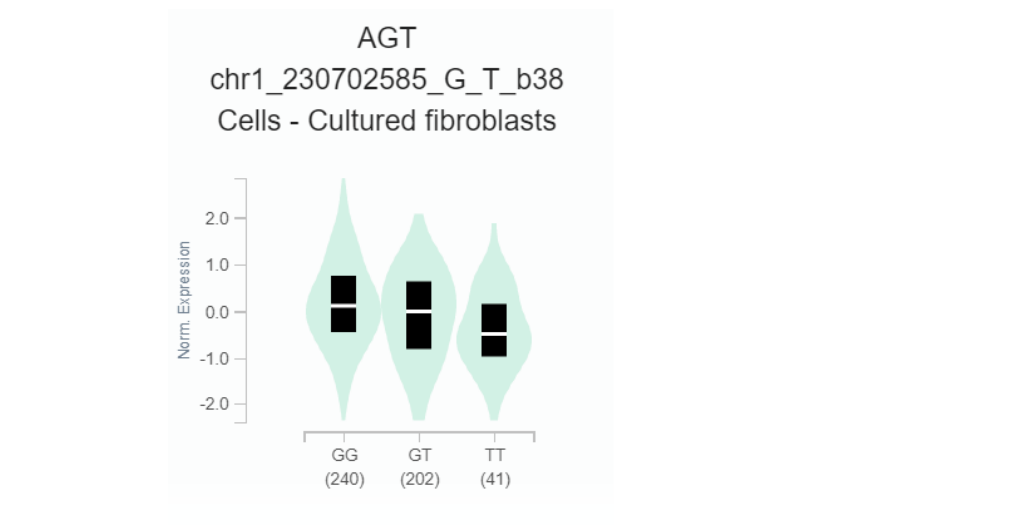
Figure 1. The effect of rs7079 G>T on Angiotensinogen ( AGT ) gene expression in cultured fibroblasts ( p = 0.000099). The gene expression data was obtained from the public database GTEx portal.